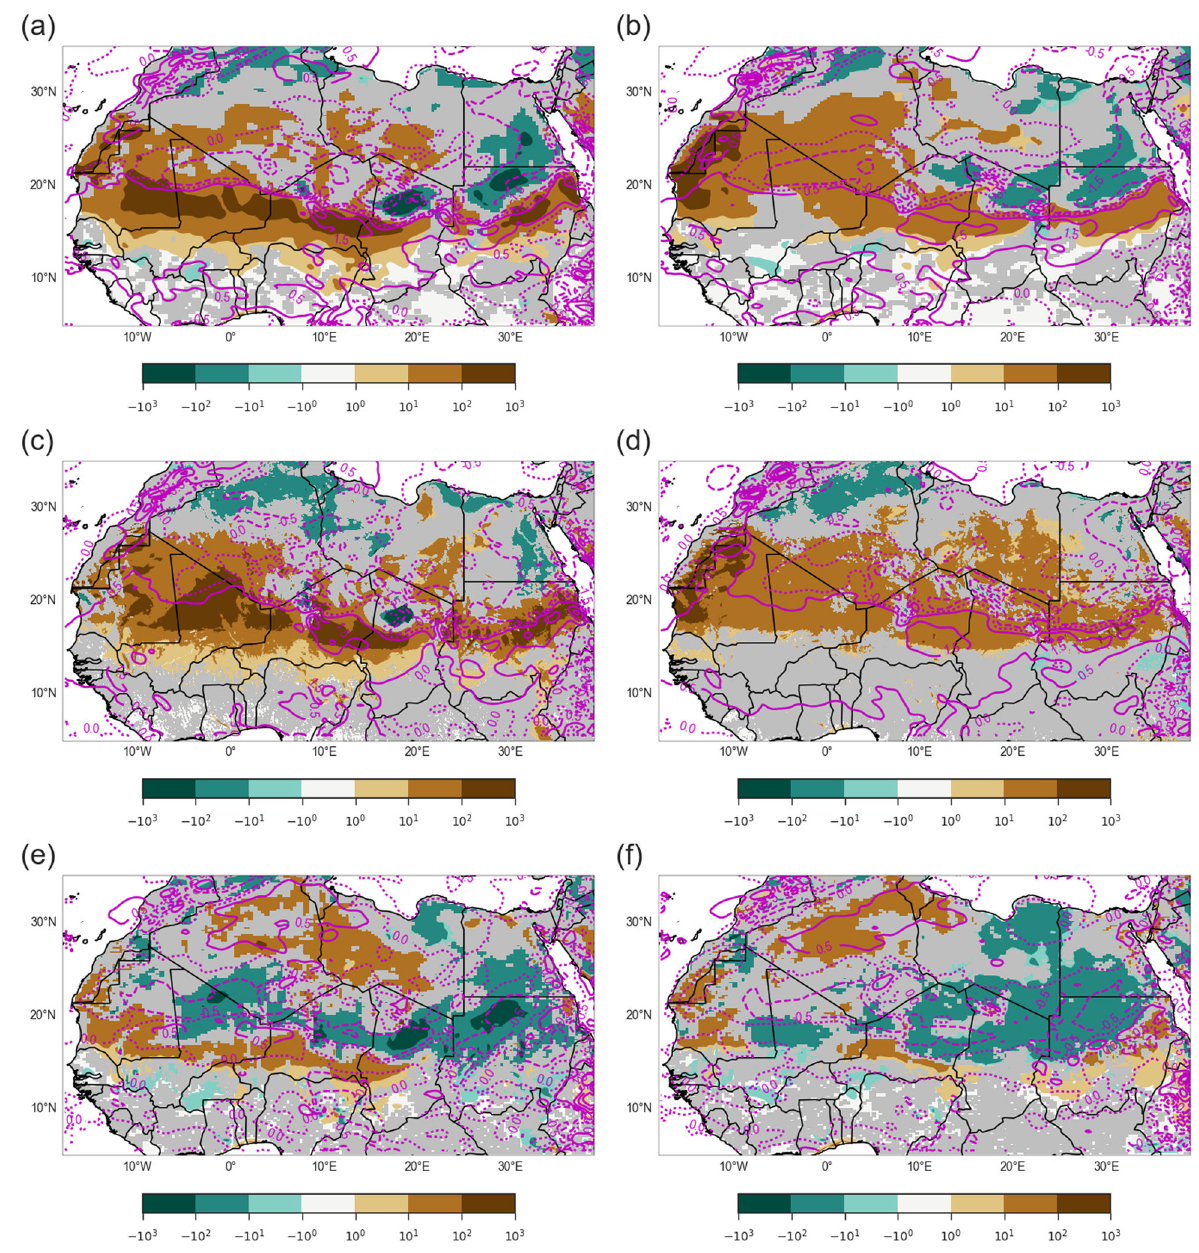
CP4, e , f (P25FC-P25)-(CP4FC-CP4). Grey shading represents non-statistically signi fi cant differences at the 5%